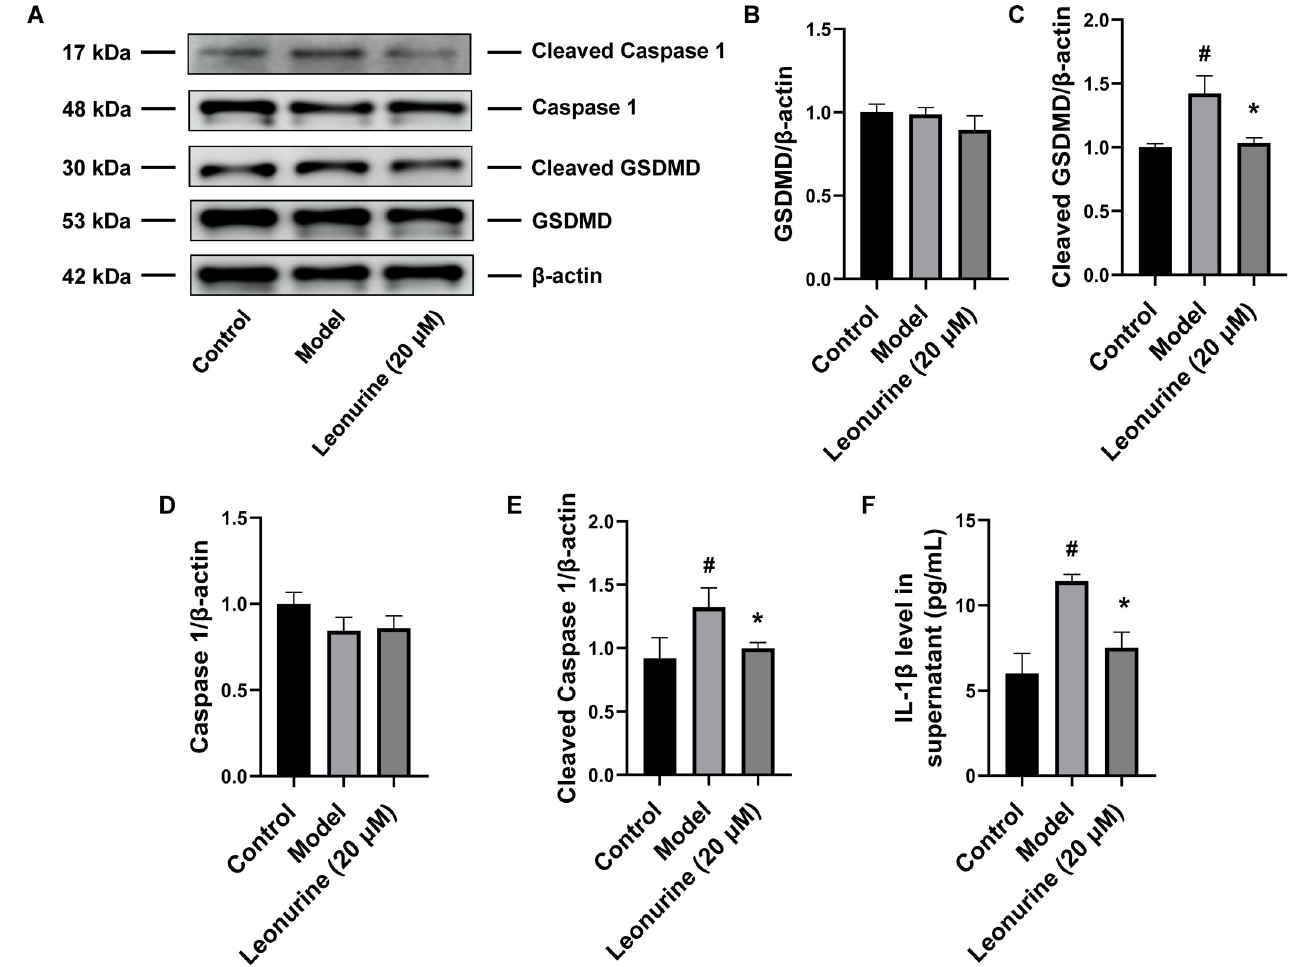
Fig 7. Leonurine reduced the expression of proteins related to pyroptosis in H9c2 cells stimulated by TGF- β . (A) Compared to H9c2 cells induced by TGF- β for 48 hours, leonurine decreased the expression of proteins related to pyroptosis including (B) GSDMD, (C) cleaved GSDMD, (D) Caspase 1, (E) cleaved Caspase 1, and the level of (F) IL-1 β . #P < 0.05, model group vs. control group; � P < 0.05, 20 μ M leonurine group vs. model